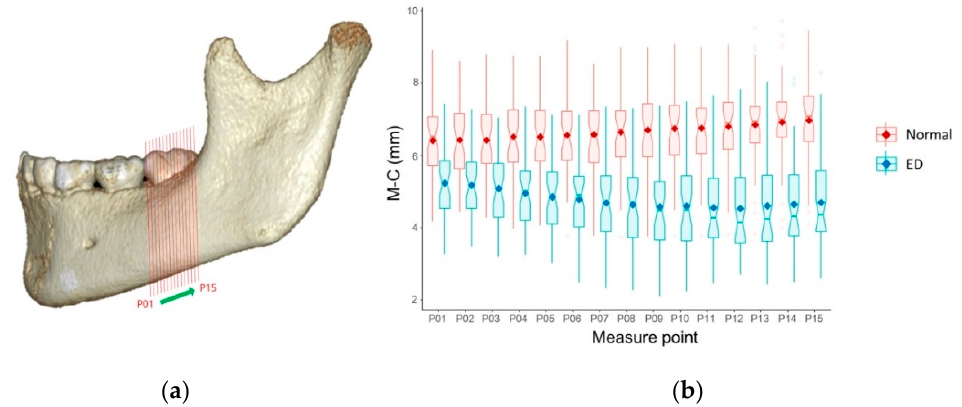
Figure 4. Mesiodistal position of the mandibular canal in relation to permanent mandibular first molar (PM1). ( a ) Reconstructed lateral view of the mandible with PM1 and measurement points; ( b ) Box plots for comparison of mean values of the distance from the most inferior margin of the mandible to the center of the mandibular canal (M–C) at each measurement point in the normal and eruption disturbance (ED) groups. The dots in the center of the boxes are mean values. These values indicate the mesiodistal position of the mandibular canal at each measurement point.